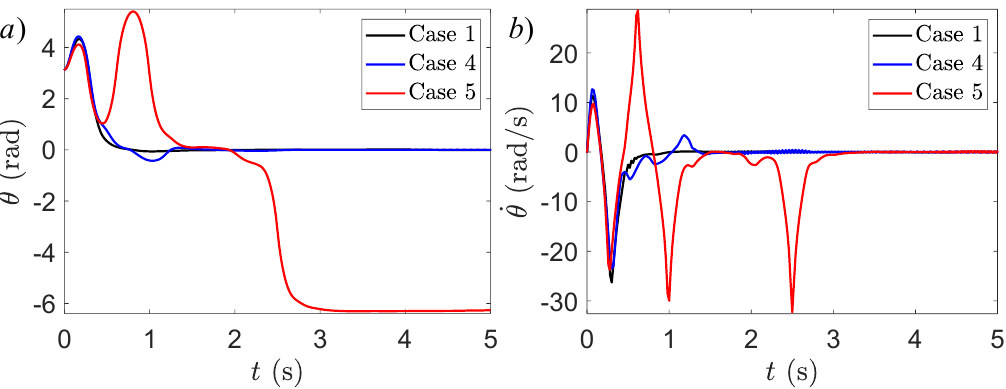
Figure 7. Pole angular position and velocity for three different values of m p . ( a ) Pole angular position during the swing-up task. ( b ) Pole angular velocity during the swing-up task.